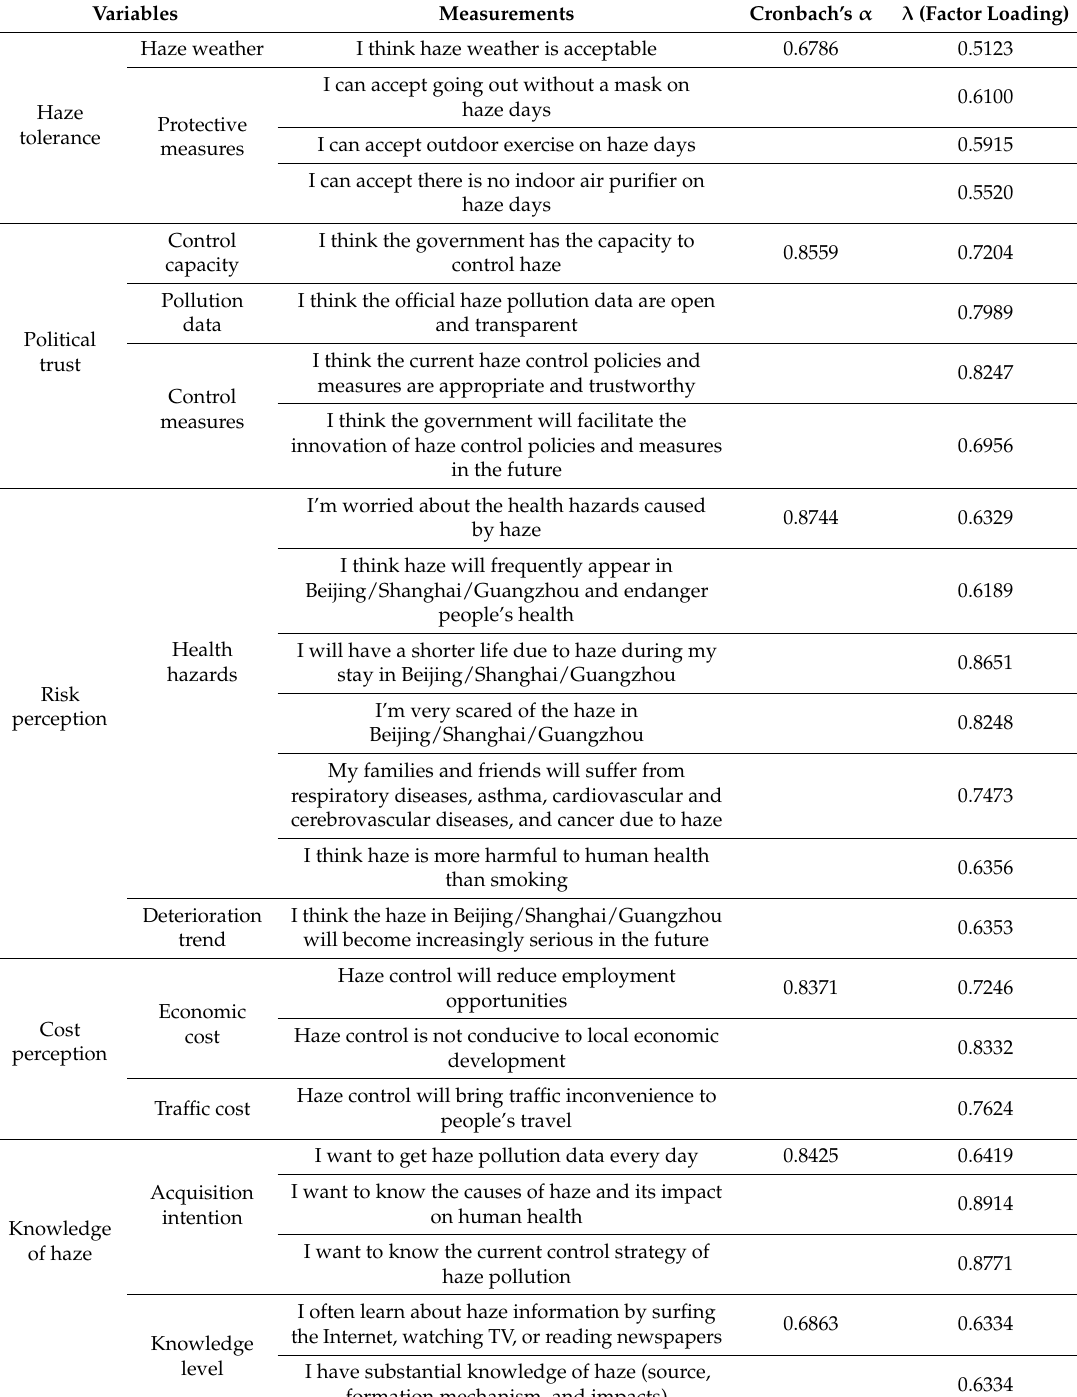
Table 2. Questionnaire of risk perception towards haze and reliability and validity